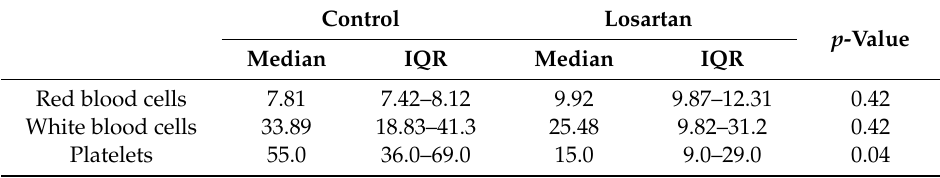
Table 4. Bone marrow concentrate (BMC) comparison between control and losartan groups in complete blood count (CBC) values. Red blood cells were measured in M / uL, while white blood cells and platelets were measured in K /